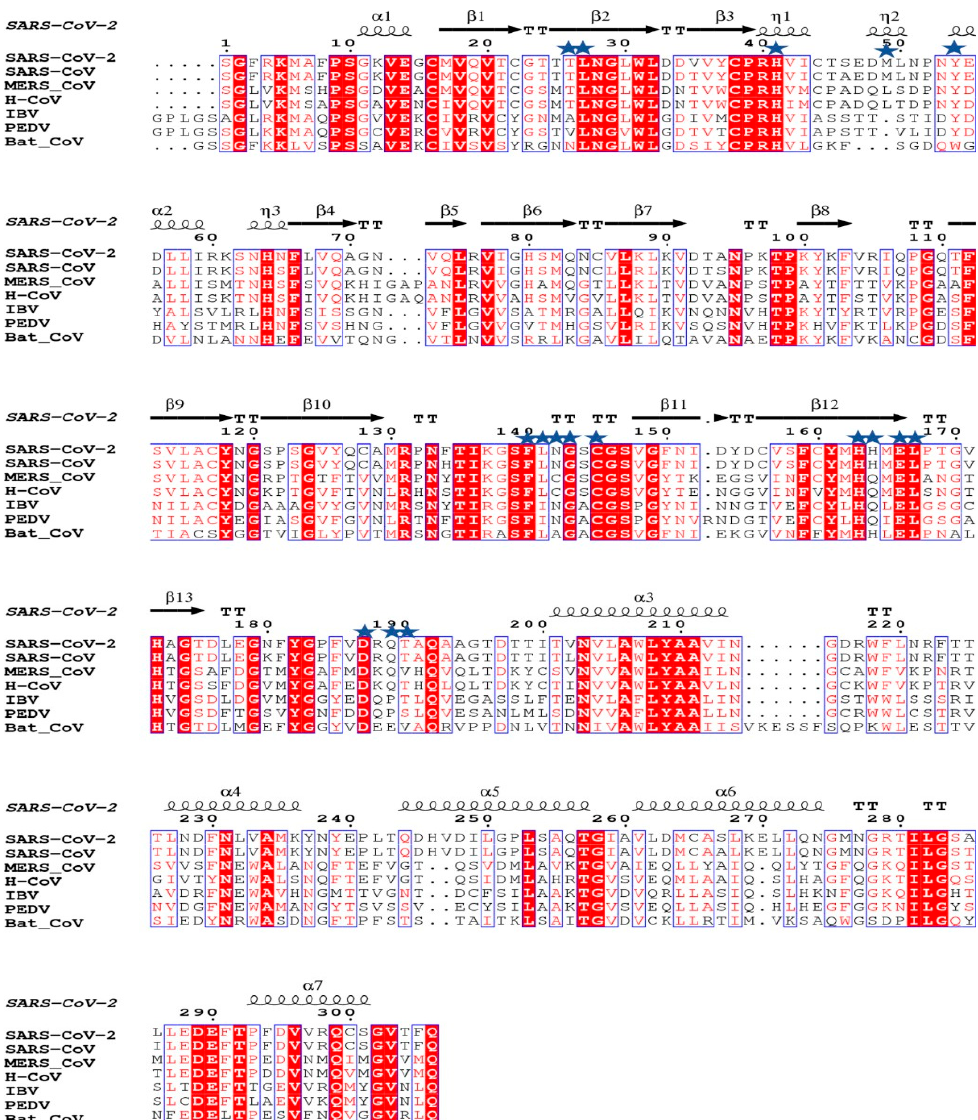
Figure 1. Multiple sequence alignment of M pro of SARS-CoV-2 with M pro of other coronaviruses performed using ESPRIPT 3.0 server. PDB ID 6M03 was used as a reference for assignment of secondary structural elements. The conserved residues involved in interaction with ligands are highlighted with blue stars. The substrate binding pocket of M pro is formed by these conserved residues.